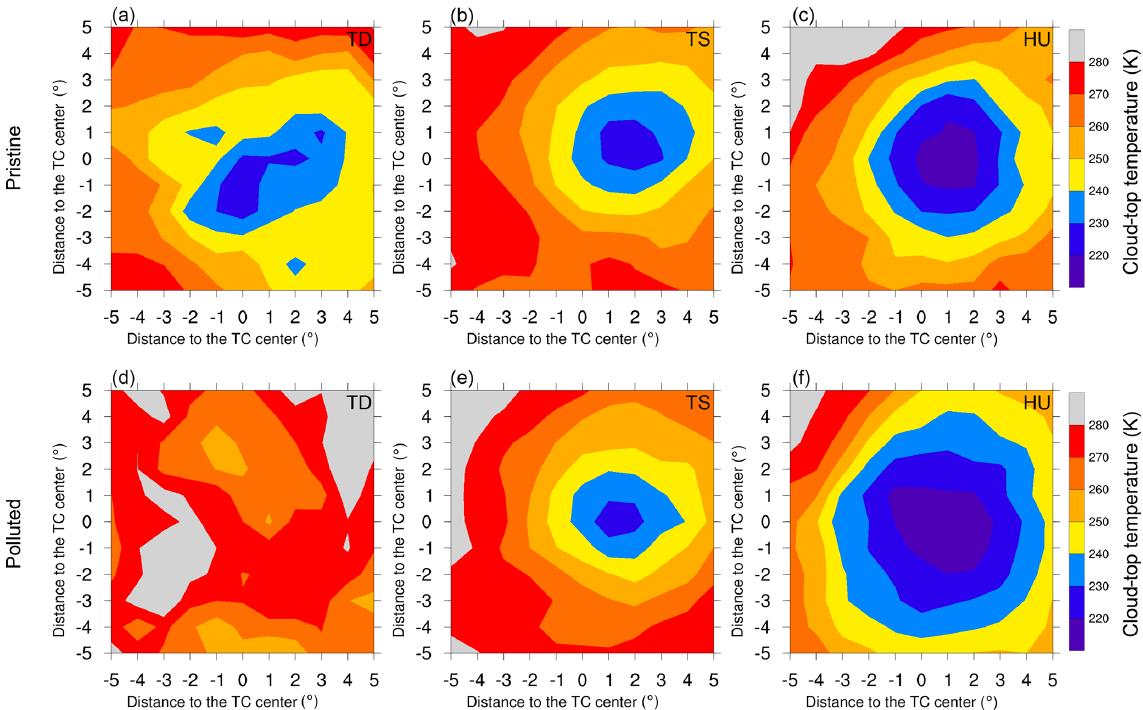
Figure 8. The spatial distributions of CTT under (a–c) pristine and (d–e) polluted conditions of the composite TD, TS, and HU,